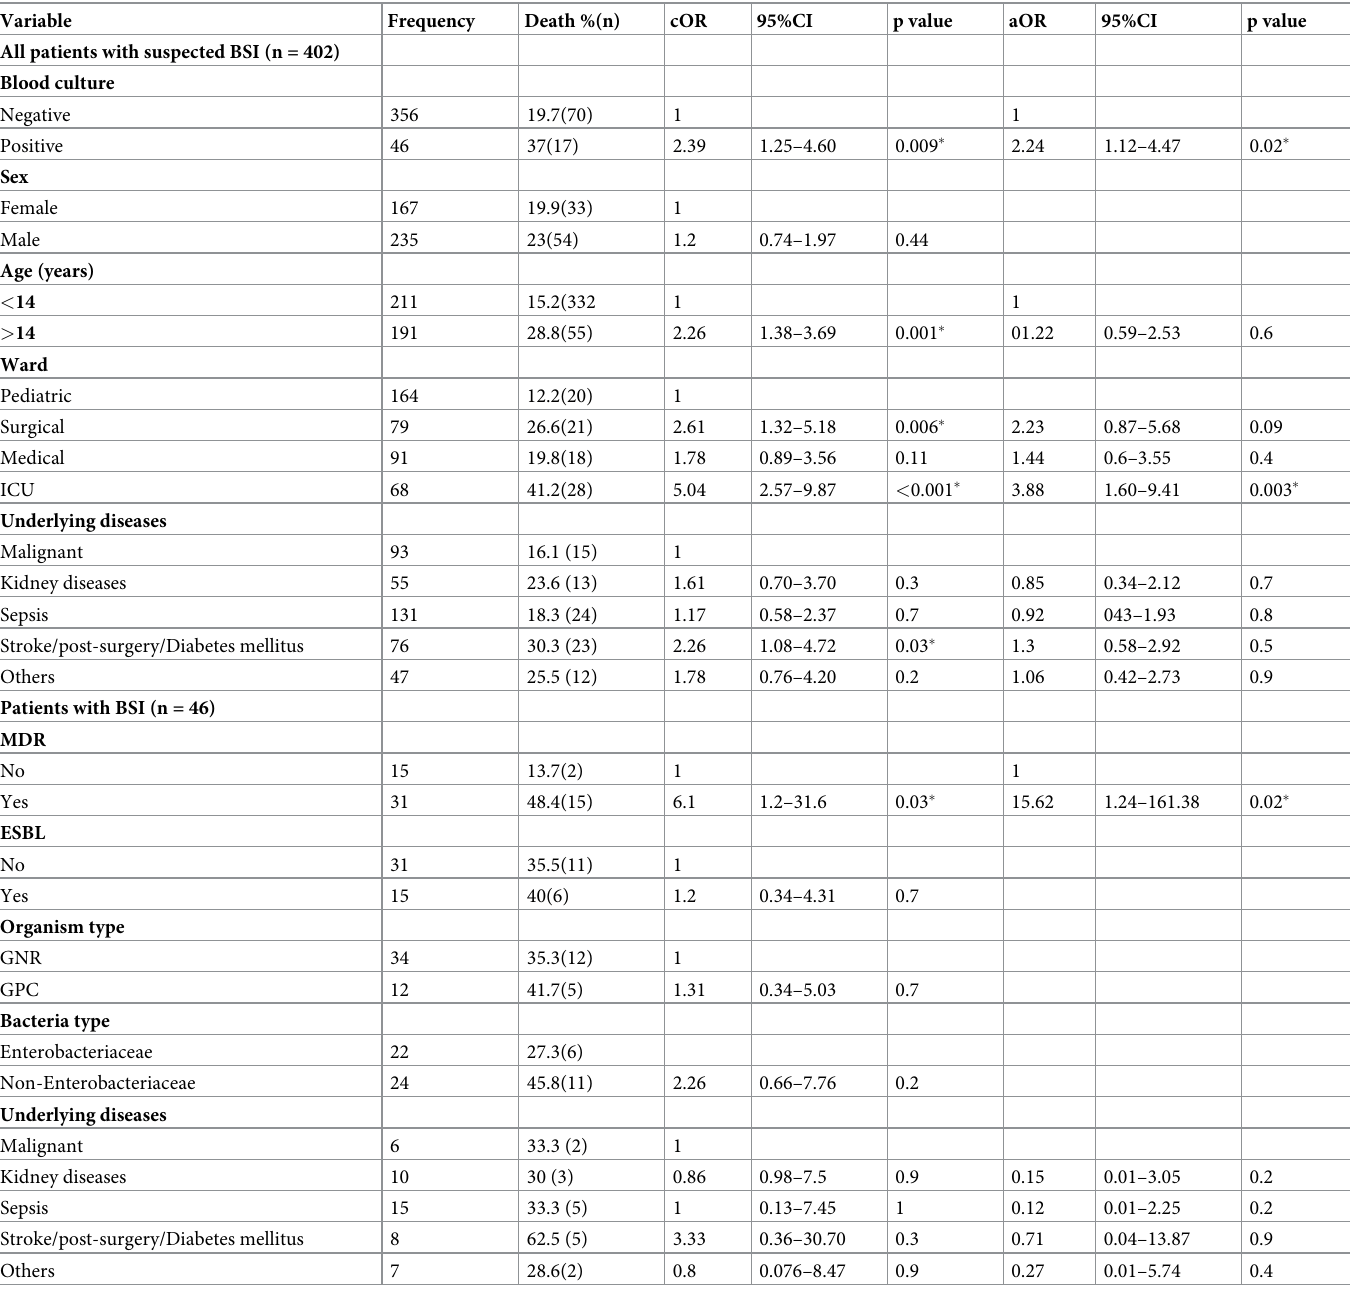
Table 4. Predictors of Mortality in Patients with suspected and confirmed Bloodstream